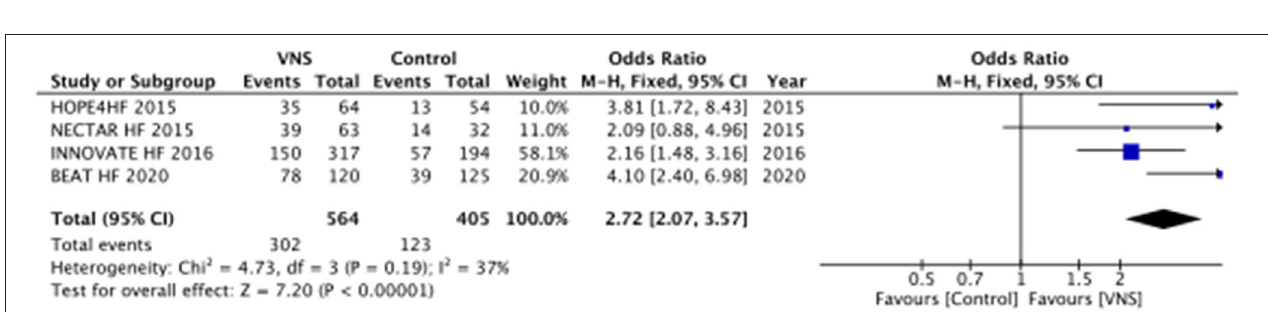
FIGURE 2 | All-cause mortality during follow-up between vagal nerve stimulation and control groups for management of chronic heart failure with reduced ejection fraction. VNS, vagus nerve stimulation.